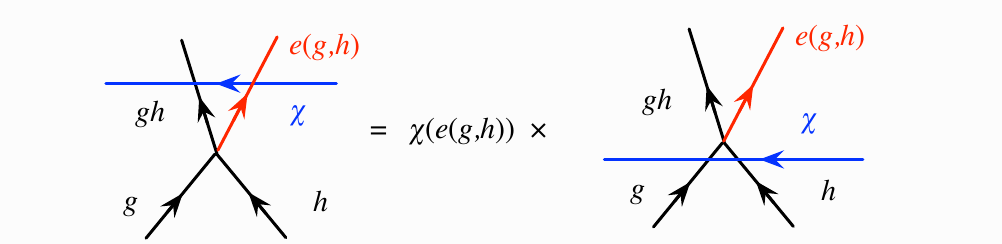
Figure 5: Combining the two facts, we find that moving the χ wall across the junction of g and h forming gh produces a phase.